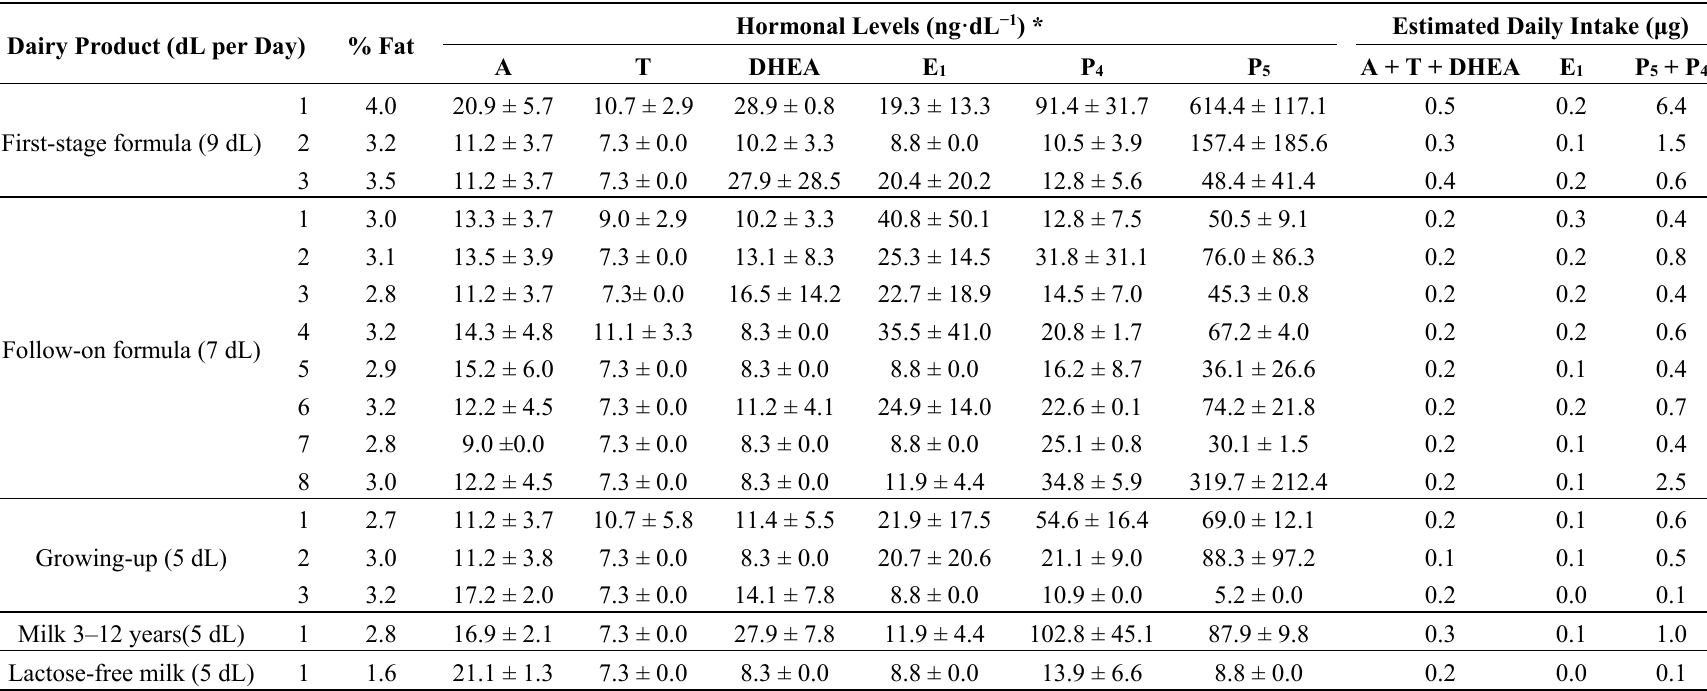
Table 1. Mean concentrations of six natural steroid hormones in different baby formulas and dairy products (ng·dL −1 ); estimated daily intake of androgens, progestogens and estrone, calculated using the estimated consumption (dL per day) of each product. Dairy Product (dL per